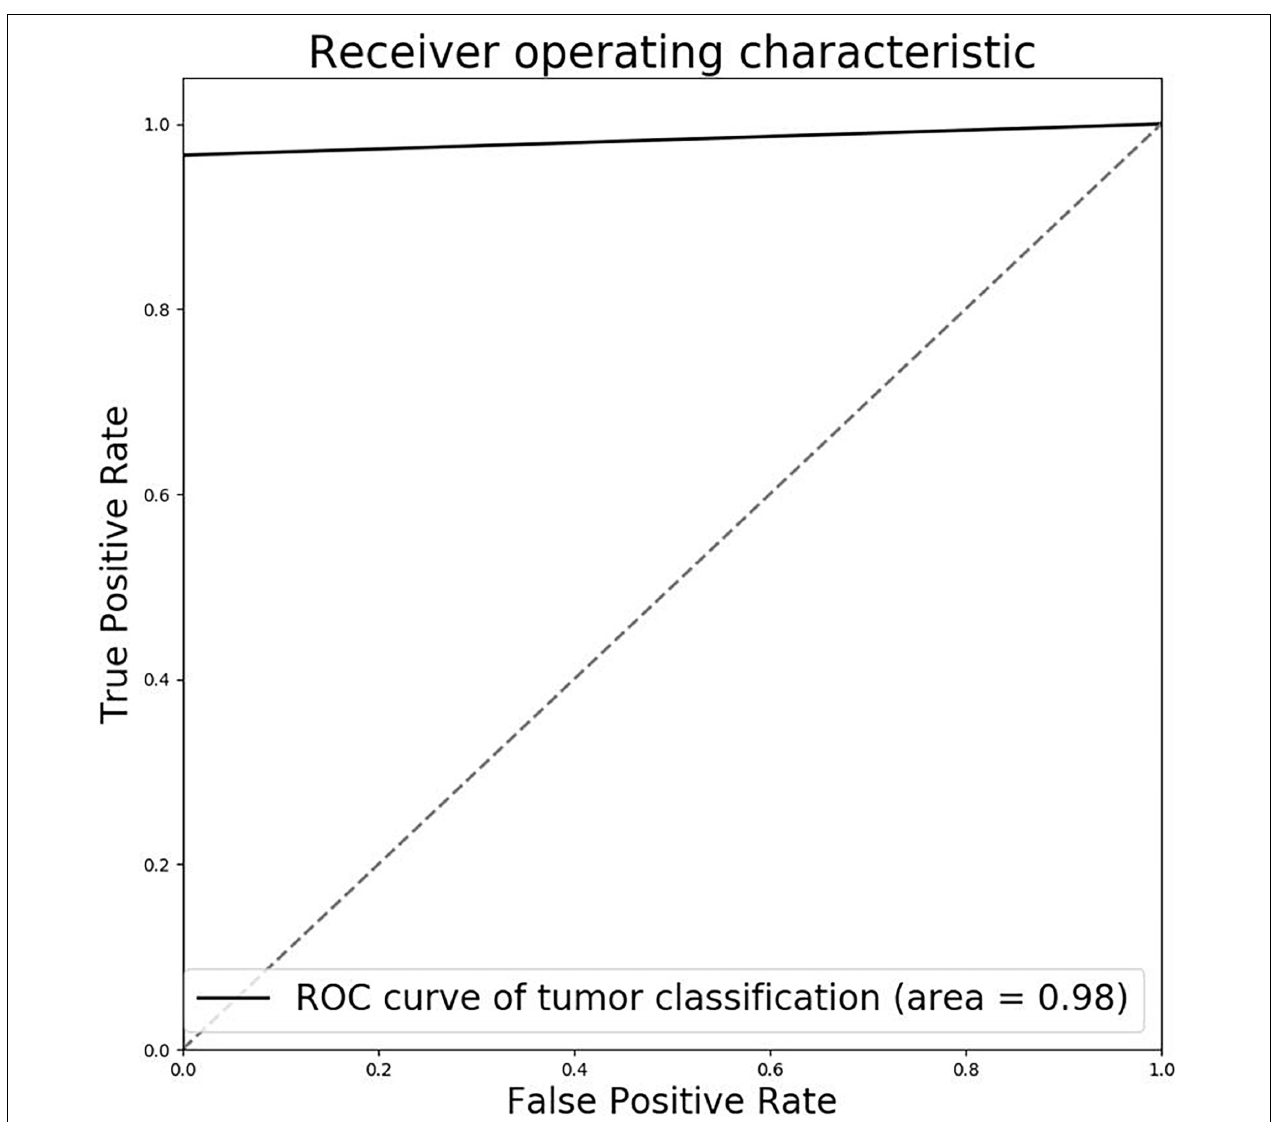
FIGURE 2 | Receiver operator characteristic (ROC) curve of tumor classification pre-trained model.